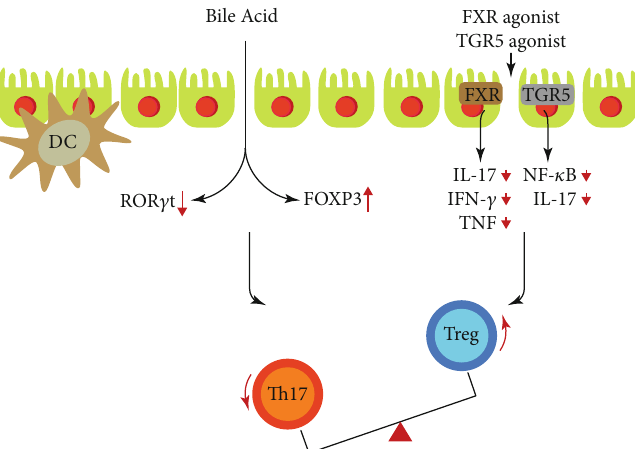
Figure 1: The role of bile acid and bile acid receptor FXR/TGR5 agonist in Th17/Treg